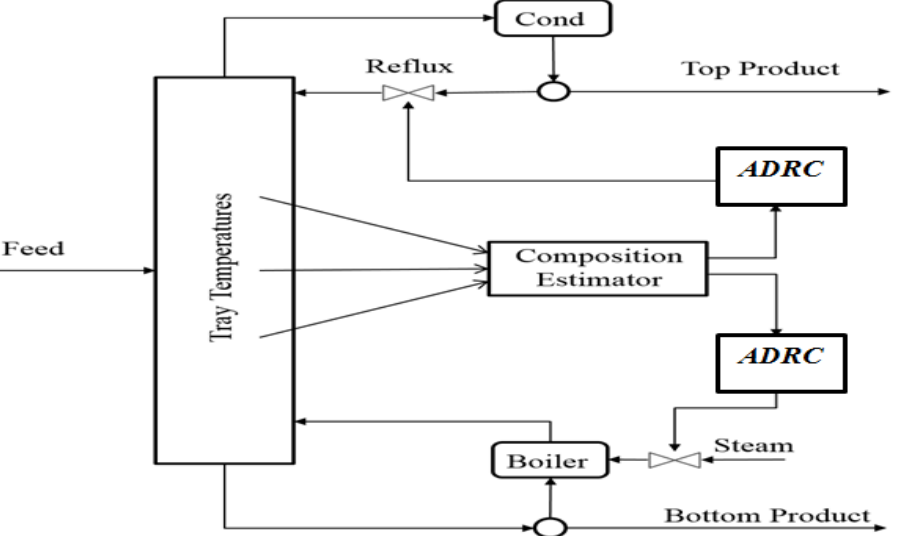
Figure 9. Inferential ADRC control of product compositions.